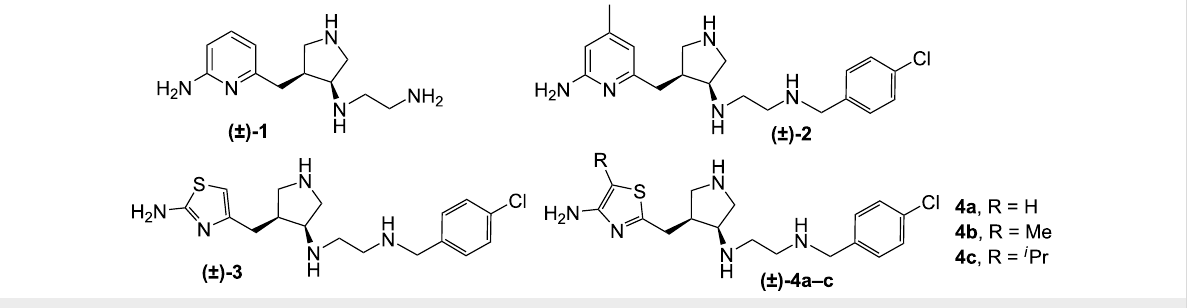
Figure 1: Lead compounds 1 and 2 ; 2- and 4-aminothiazole analogs 3 and 4a - c .